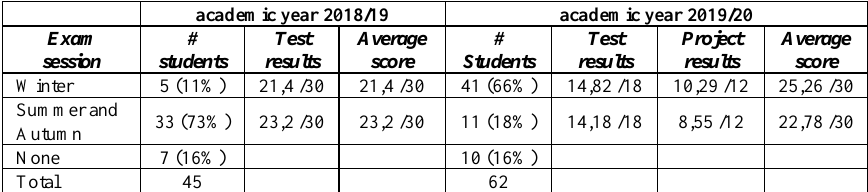
Table 3. Students distribution at the assessment and their average